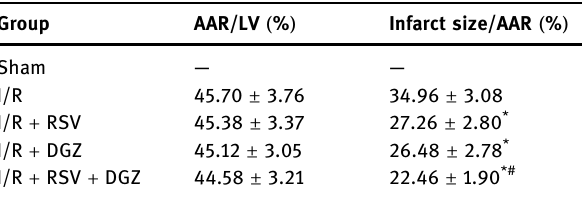
Table 1: E ff ect of the RSV and DGZ on AAR/LV and infarct size in hearts Group AAR/LV ( % ) Infarct size/AAR ( % ) Sham